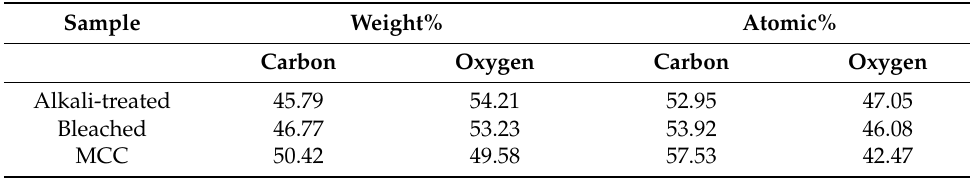
Figure 4. SEM images indicating variation in morphology of alkali-treated ( a , b ), bleached ( c , d ), and acid-hydrolyzed ( e , f ) samples at a resolution of 100× ( a , c , e ) and 1000× ( b , d , f ), respectively. acid-hydrolyzed ( e , f ) samples at a resolution of 100 × ( a , c , e ) and 1000 × ( b , d , f ), respectively. Table 1. Elemental composition of alkali-treated, bleached, and MCC samples. Table 1. Elemental composition of alkali-treated, bleached, and MCC